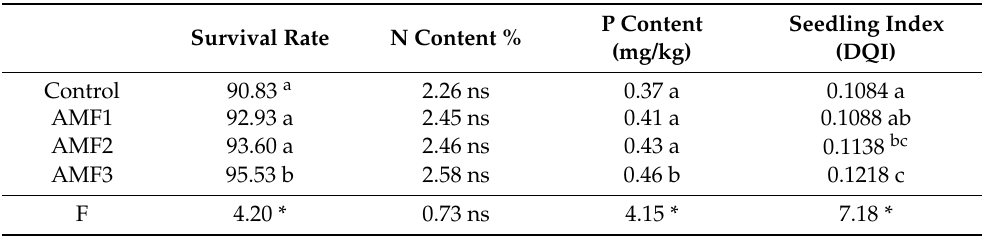
Table 2. The survival rate, seedling index, and nitrogen and phosphorus accumulation as affected by different treatments of AMF.